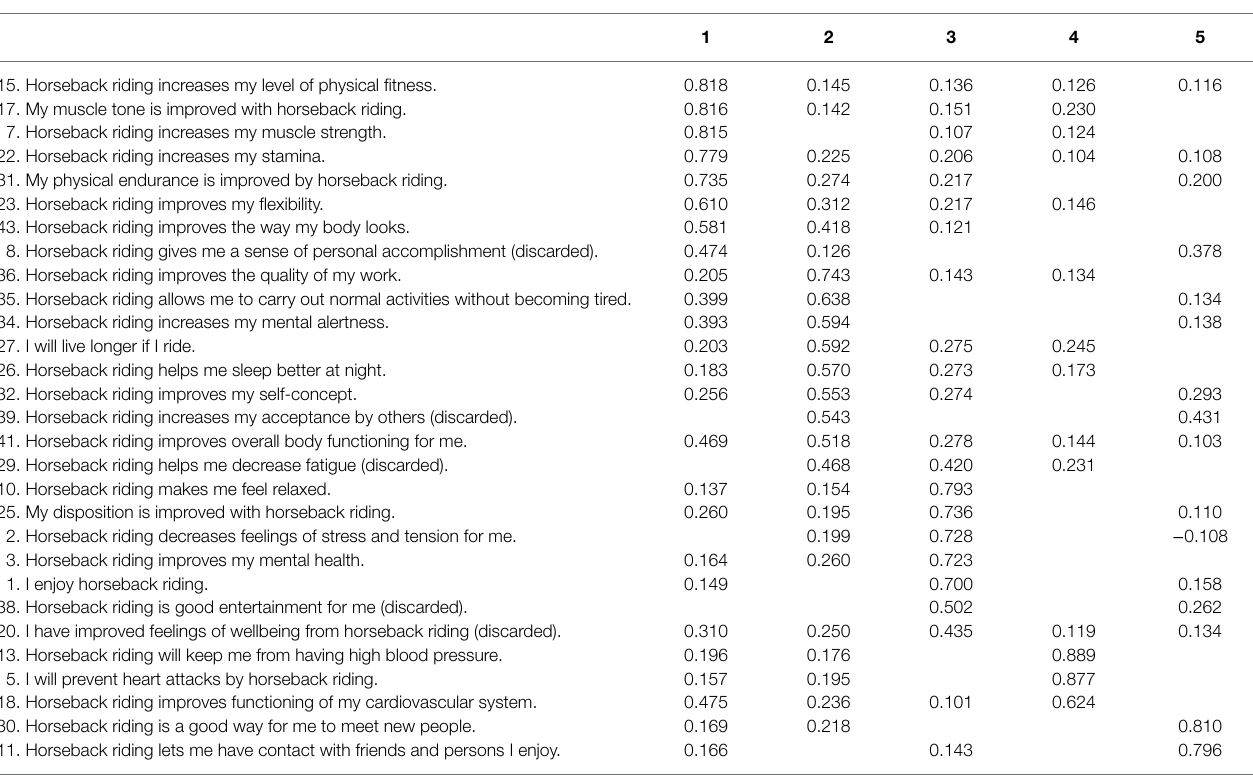
TABLE 1 | Benefit indicators’ principal component analysis.